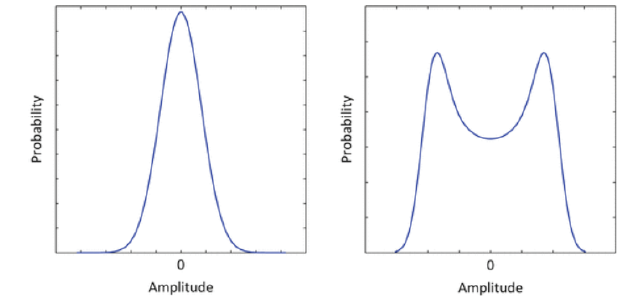
Figure 13. Comparison between the different shapes of a nor- malised PDF of a structural mode (left) and a harmonic (right) (Motte et al.,